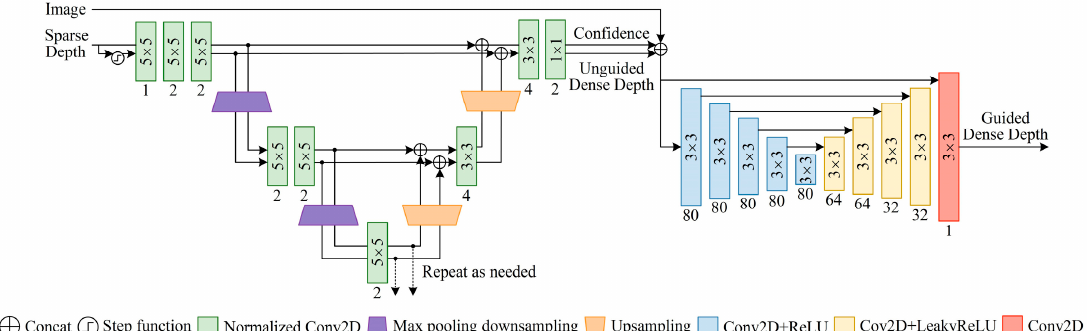
Figure 2. Depth completion network. The sparse depth maps and RGB images are used as inputs, and the input con fi dence level in the normalized convolution is objected by calculating the binary mask with the step function. Finally, the dense depth maps guided by con fi dence are the output.